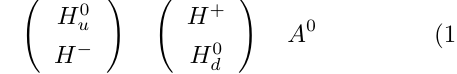
Figure 2: Observed (solid line) and expected (dashed line) 95% CL upper limit on the ratio of the product of production cross section and branching ratio to the SM expectation for the Higgs boson (from Ref.